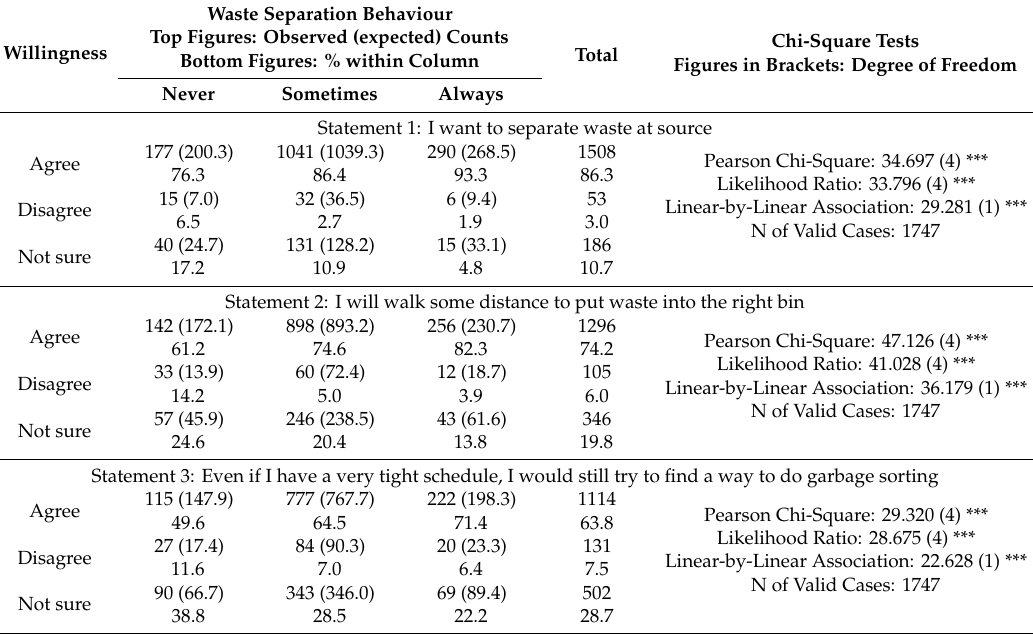
Table 5. Willingness to separate waste and waste separation behaviour.